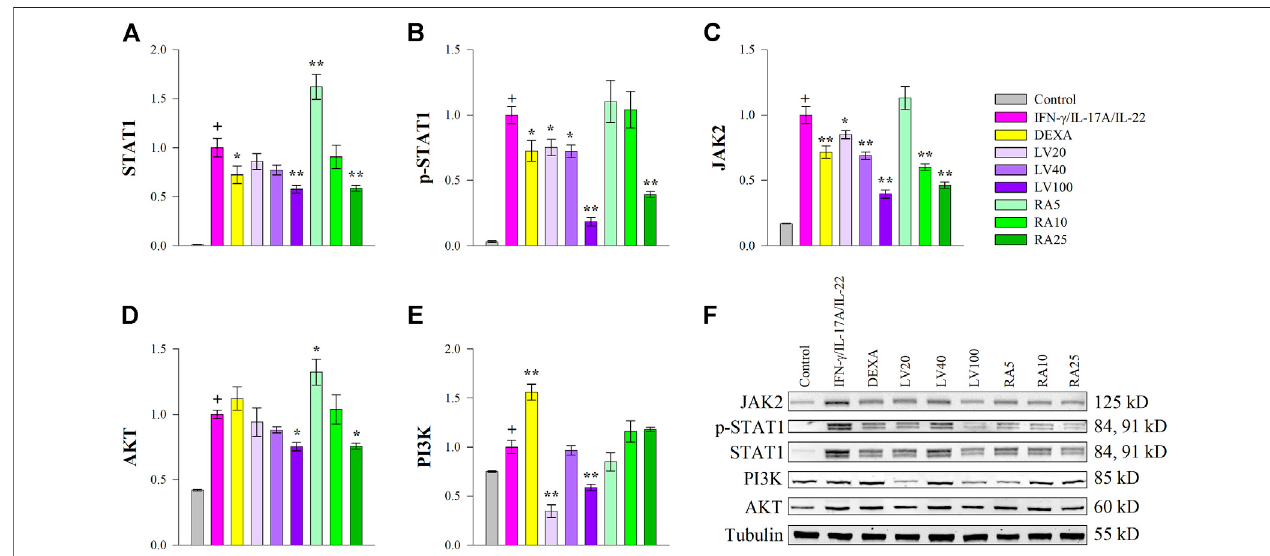
FIGURE 3 | Lavandula angustifolia extract (LV) and pure rosmarinic acid (RA) both inhibit JAK2/STAT1 signaling in HaCaT cells. Protein expression of STAT1 (A) , phosphorylated STAT1 (B) , JAK2 (C) , AKT (D) and PI3K (E) and representative bands from the Western blotting analysis (F) . The results are presented as mean ± SEM from three independent experiments. + p < 0.05 compared to control cells; * p < 0.05 and ** p < 0.01 compared to psoriasis-like model